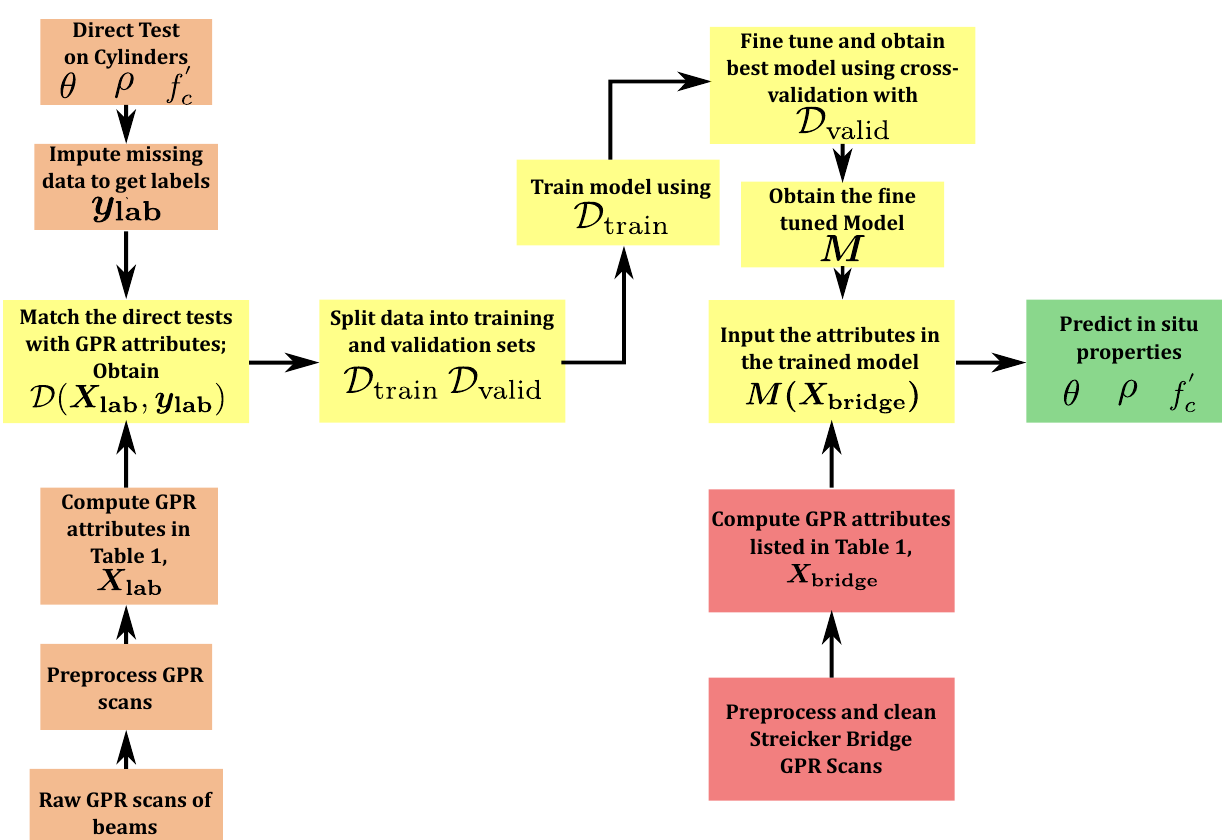
Figure 9. Flowchart depicting the steps involved in estimating the material properties using a machine learning